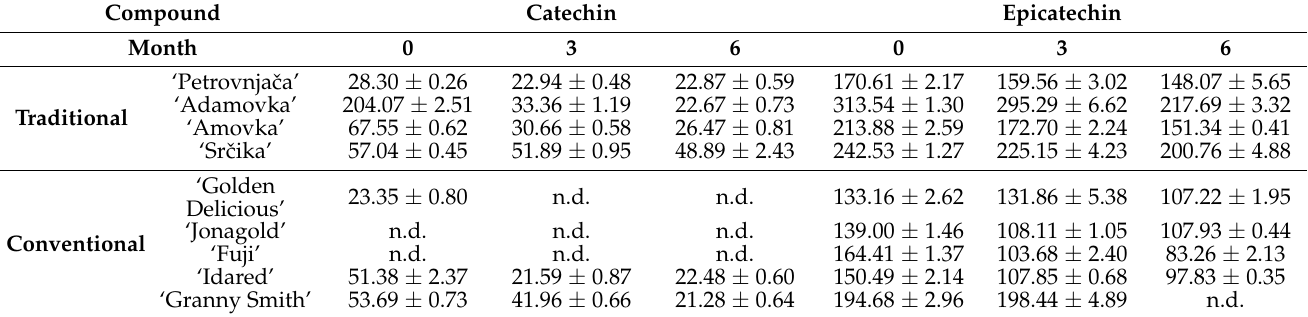
Table 2. The content of flavanols ( µ g/g dw a ) in the traditional and conventional apple